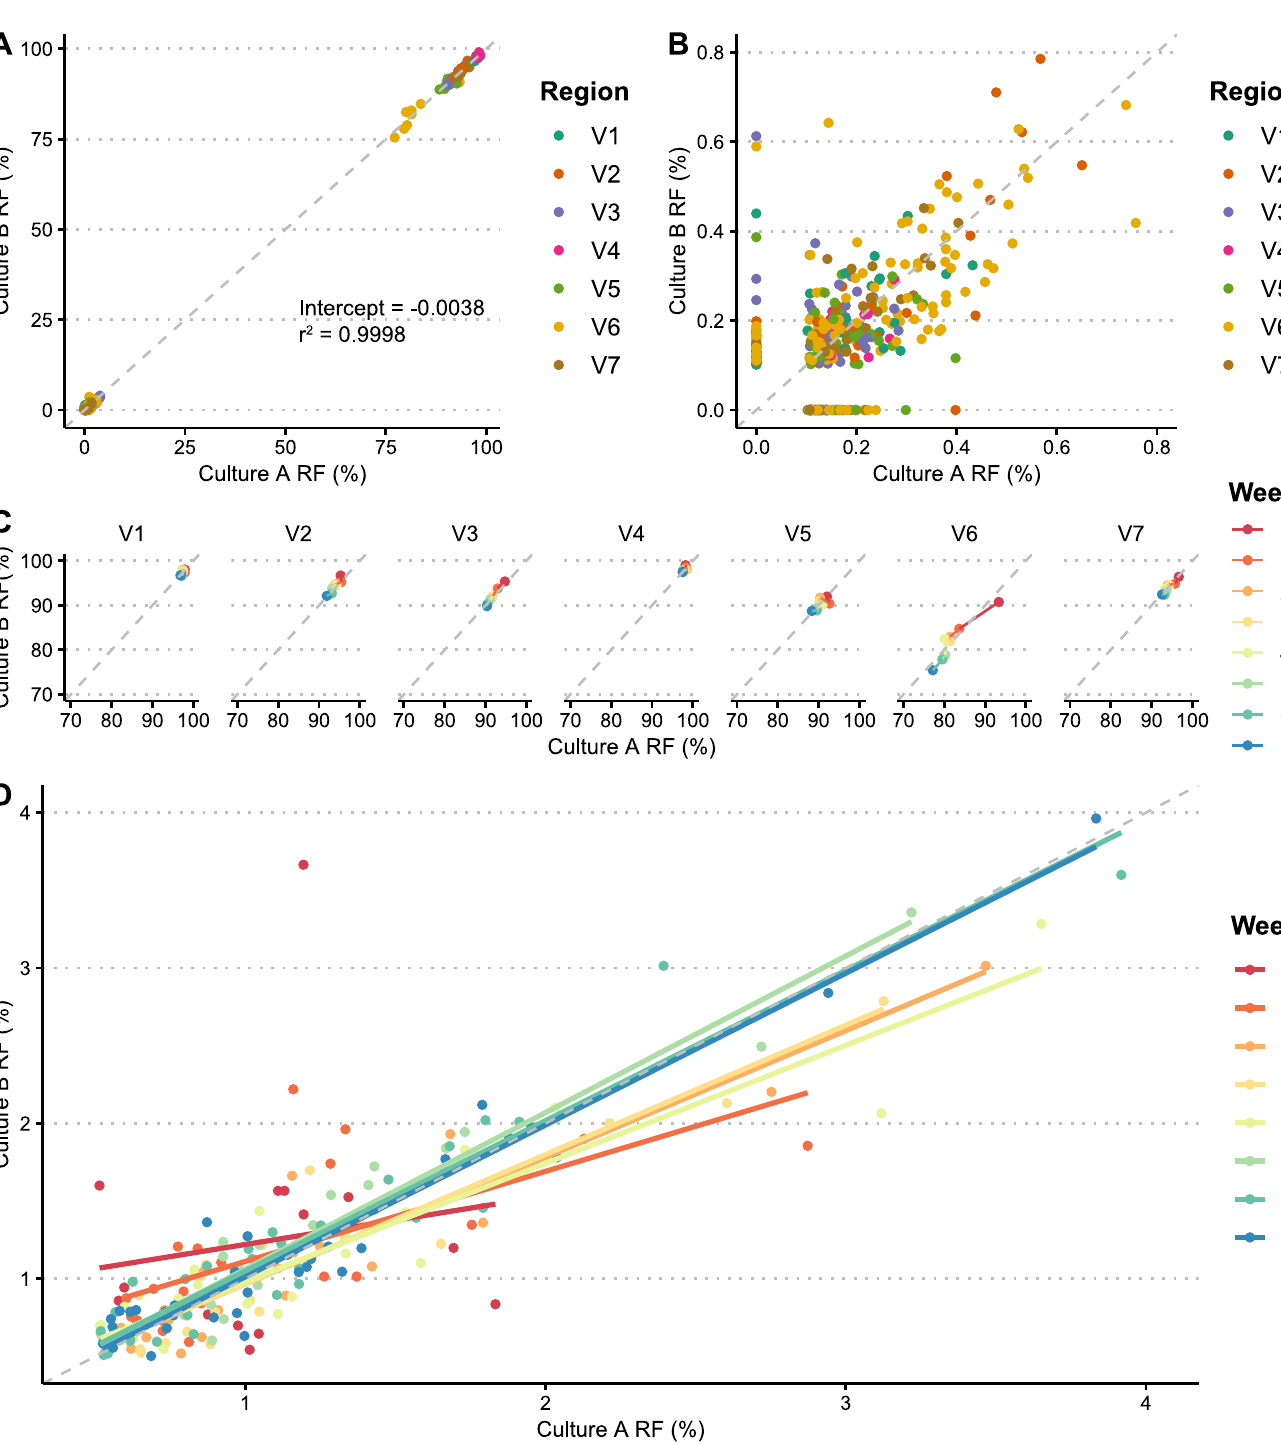
PLOS NeglectedTropical Diseases | https://doi.org/10.1371/journal.pntd.0009753 September 7, 2021 12 /